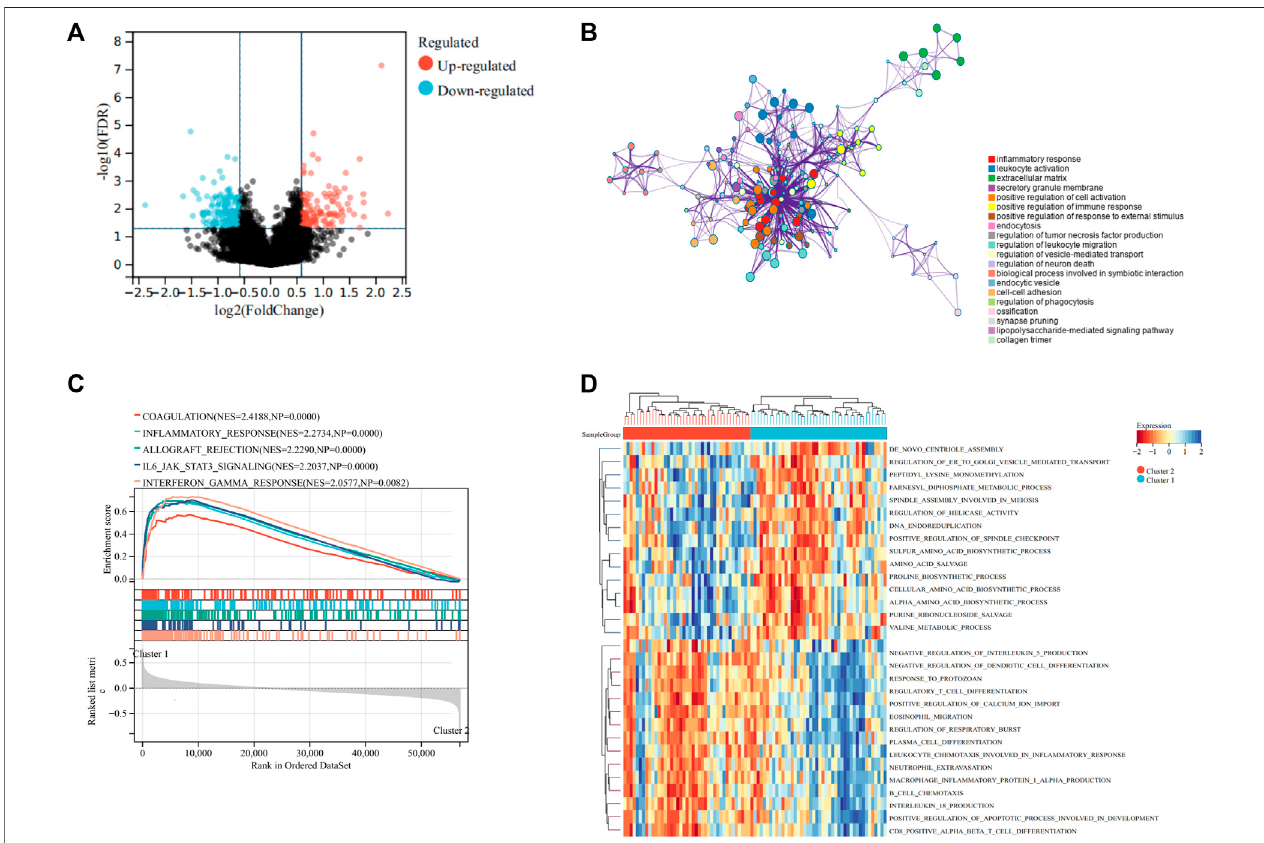
FIGURE 3 | Differentially expressed genes and functional enrichment analyses. (A) Volcano plot showing the DEGs between the two subgroups. (B) Bubble plot exhibitedthefunctionalenrichmentofDEGsthroughGOanalysis. (C) GSEAshowsthehallmarkgenesetsinthetwosubgroups. (D) Heatmapdepictedtheresultsofthe GSVA